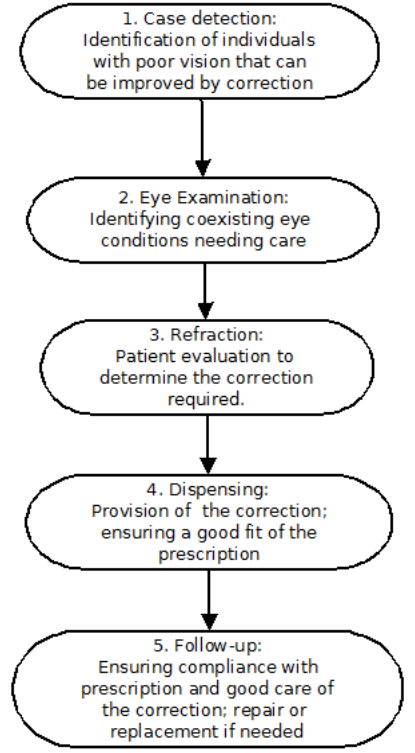
Figure 1. The general steps in the provision of refraction